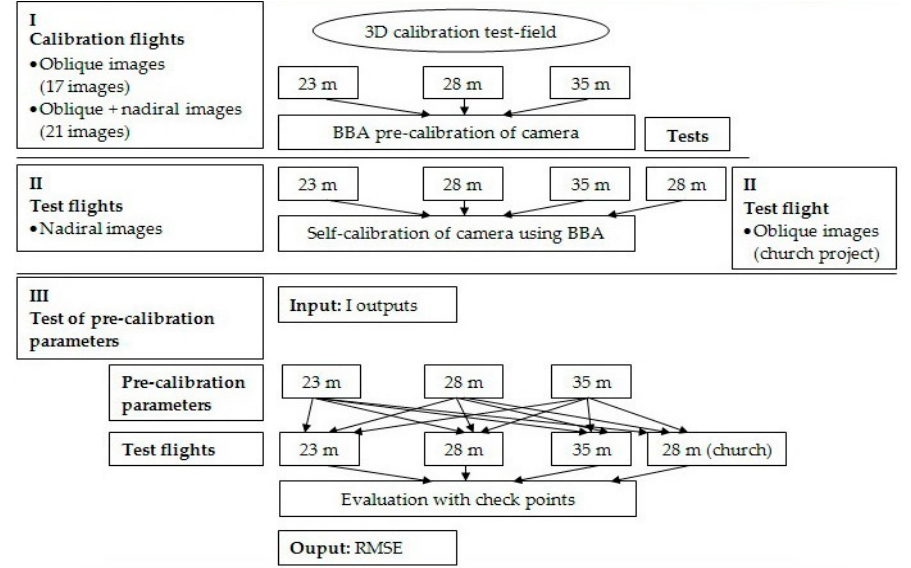
Figure 7. Experiments workflow.